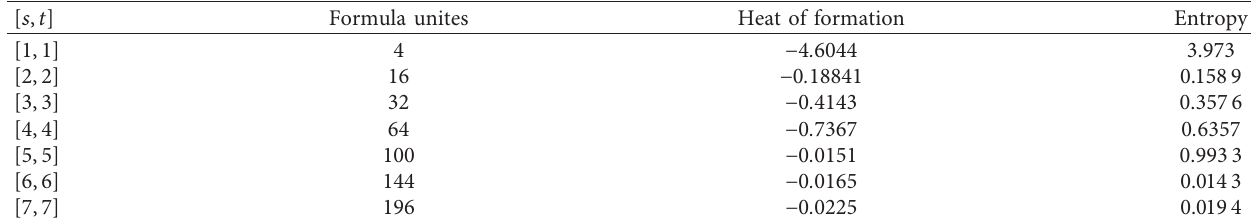
Table 4: Heat of formation and entropy for all formula unites of InP [ s , t ]. [ s, t ]